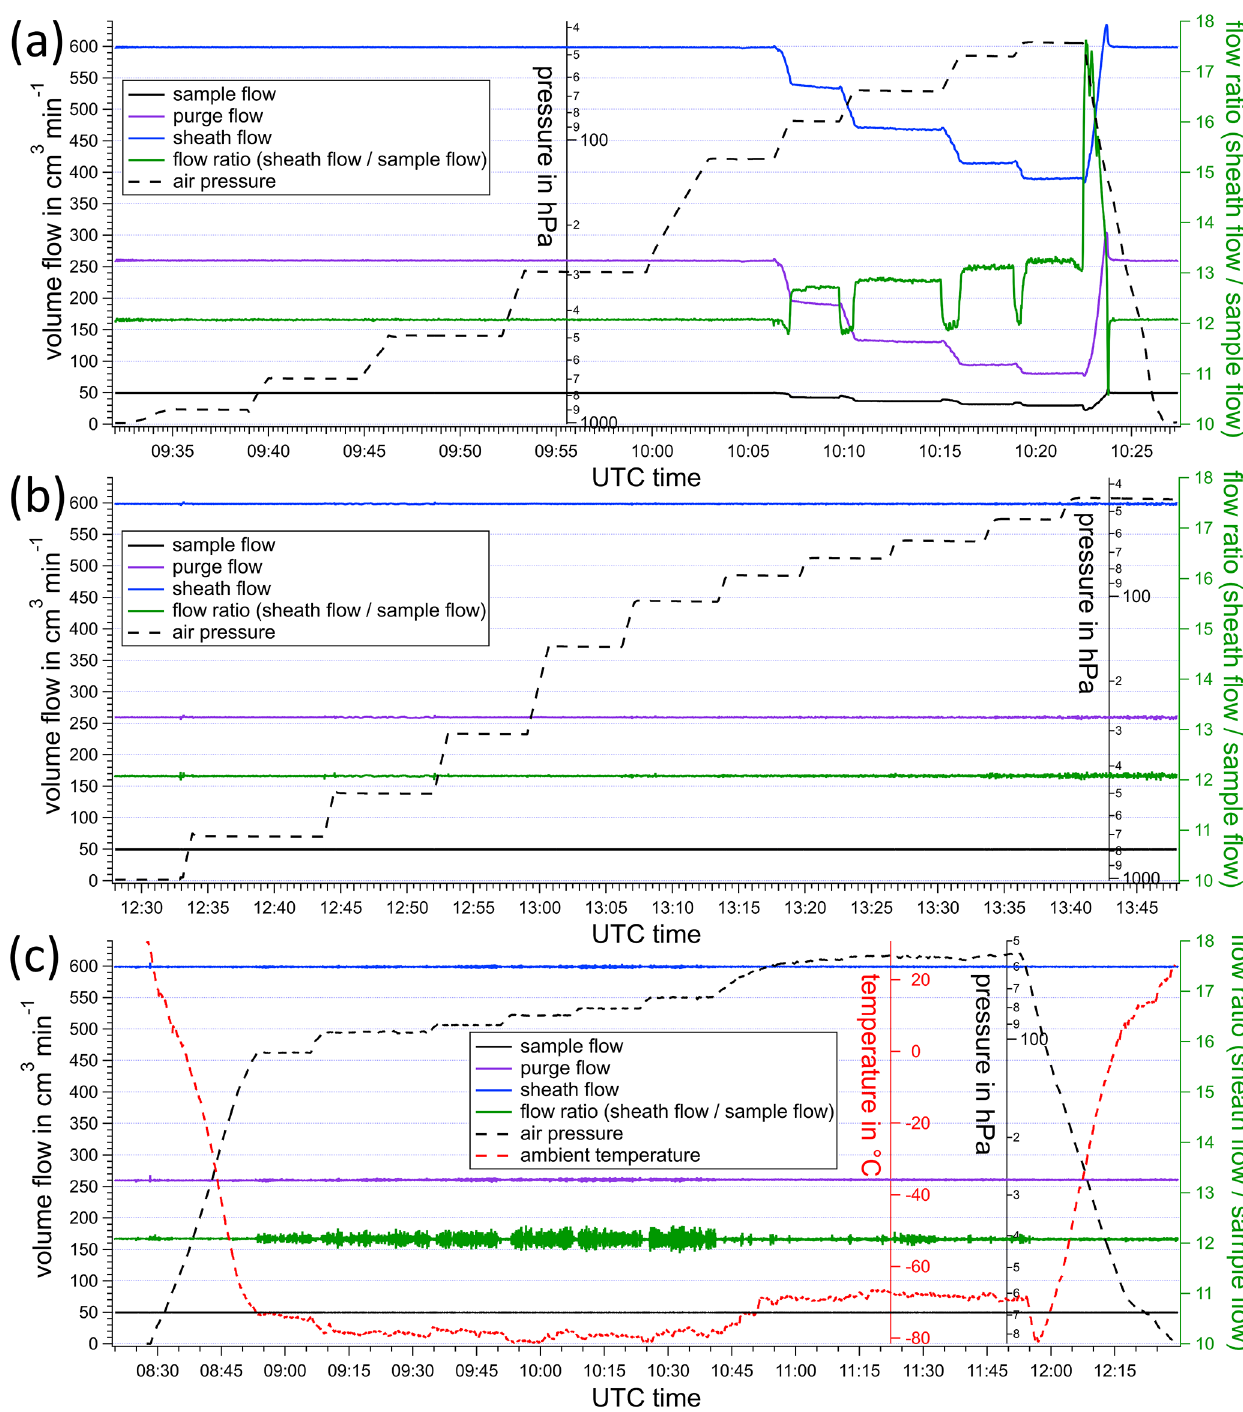
Figure A1. Time series of the UHSAS-A internal flow measurements (sample flow, sheath flow, and purge flow), the ratio between sheath and sample flow, and the air pressure during low-pressure chamber tests with the original pump system of the UHSAS-A (a) and with the new integrated pump system (b) . Panel (c) shows the time series for the StratoClim 2017 flight KTM4 (with the new pump system), also including the ambient static air